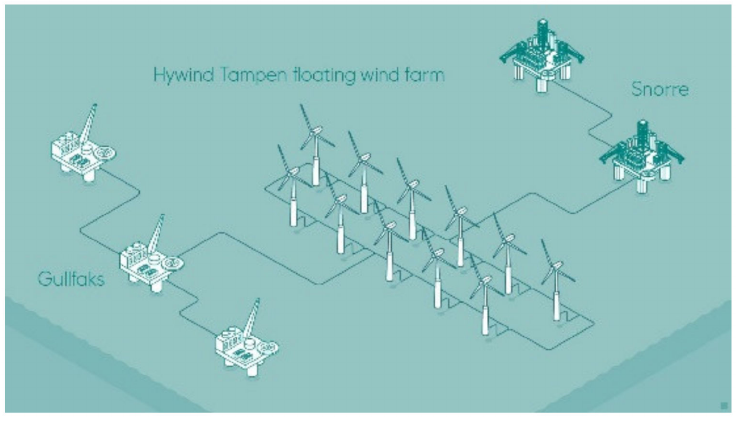
Figure 3. Hywind